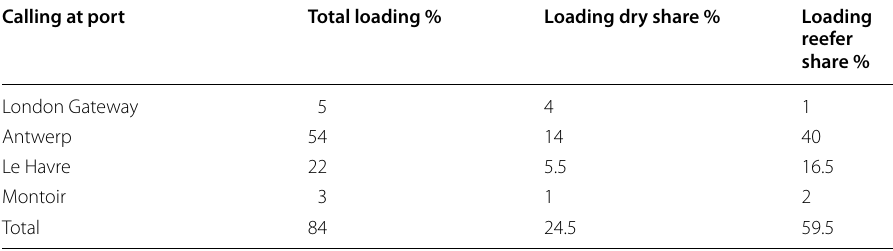
Table 8 Loading cargo % of the vessel at European ports– scenario 1 Calling at port Total loading % Loading dry share % Loading